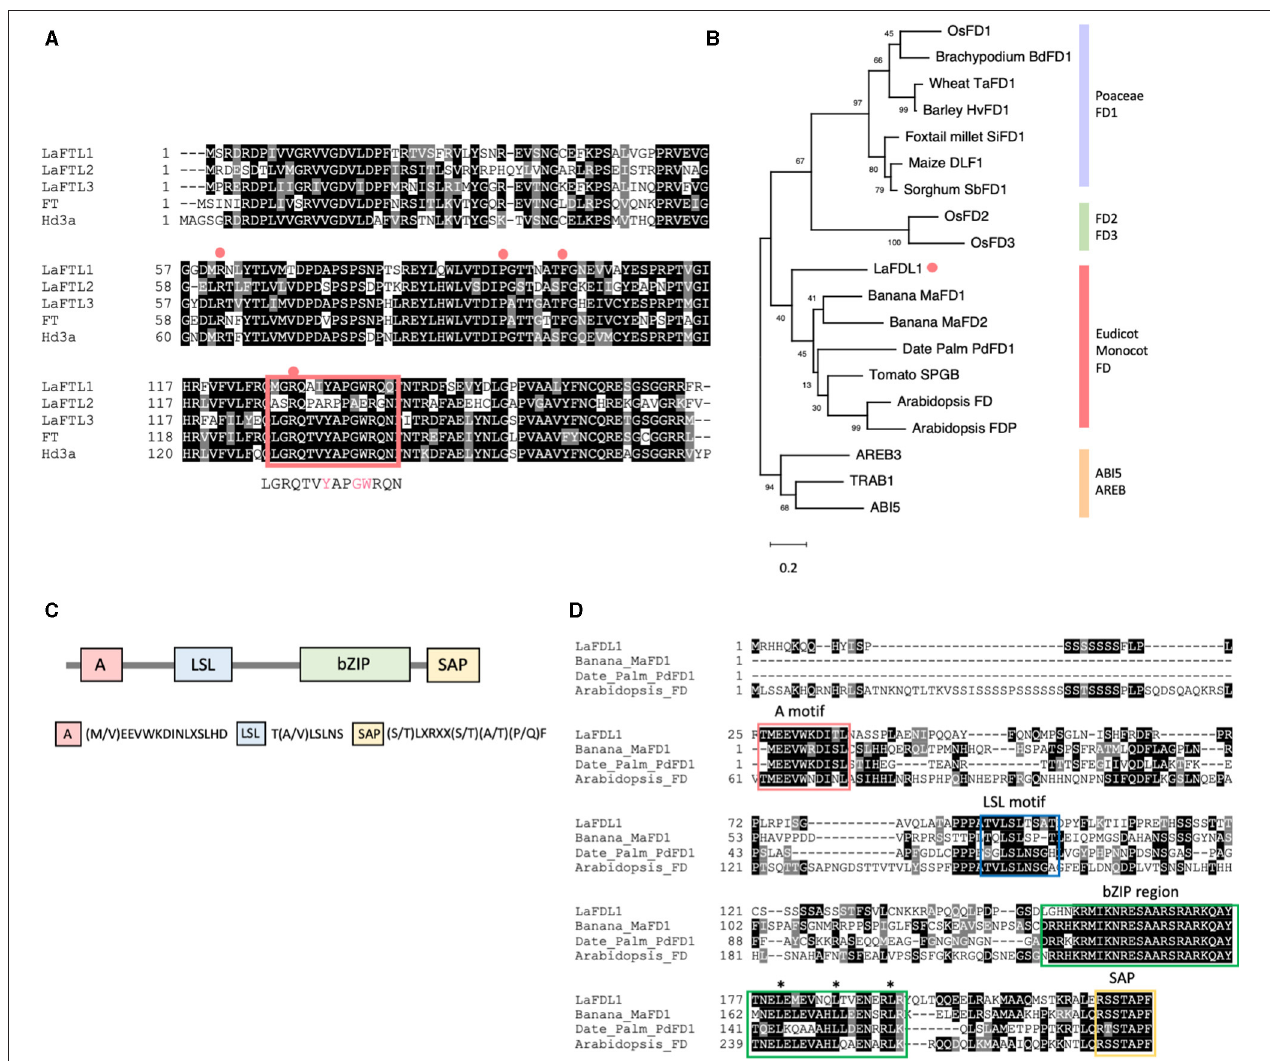
FIGURE 5 | FT and FD-like proteins in L. aequinoctialis. (A) Deduced amino acid sequences and alignment of two FT-like proteins from L. aequinoctialis , rice Hd3a, and Arabidopsis FT. Gene IDs and accession numbers are provided in Supplementary Table 5 . The four amino acid residues important for 14-3-3 protein binding in Hd3a are identified by red circles above the alignment. The red rectangle indicates the loop region of segment B. The consensus sequence for this region is shown below the alignment. (B) A phylogenetic tree of the FD-like protein family. The sequences were aligned by MUSCLE and the conserved residues were trimmed by trimAl. A phylogenetic analysis was conducted using the MEGA X program with 500 bootstrap replications. A maximum-likelihood tree was constructed using the Jones-Taylor-Thornton model. Representative FD-like proteins from monocots and dicots (Supplementary Table 5) were used to draw the tree. LaFDL is marked with an orange dot. (C) A schematic drawing of FD1 from non-Poaceae monocots FD1. The four conserved motifs (A, LSL, bZIP, and SAP) are shown. (D) Alignment of LaFDL1, Arabidopsis AtFD, Banana MaFDL1, and Date palm PpFDL1. The four conserved motifs are indicated by colored boxes. Asterisks indicate heptad repeats of leucine residues comprising the leucine-zipper